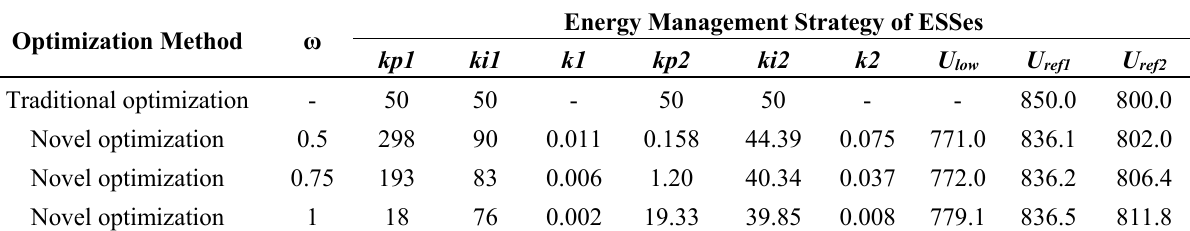
Table 8. The parameters of optimal energy management strategies.